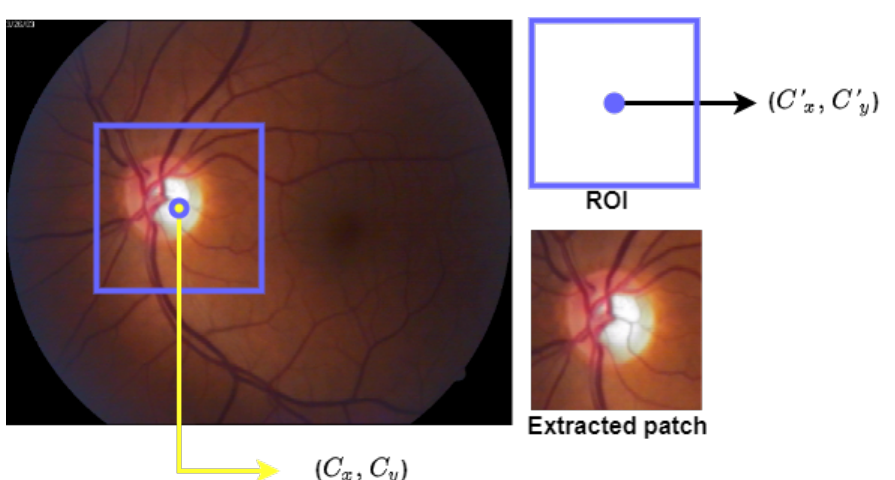
Figure 4. Example of the alignment between the proposed ROI with the RGB